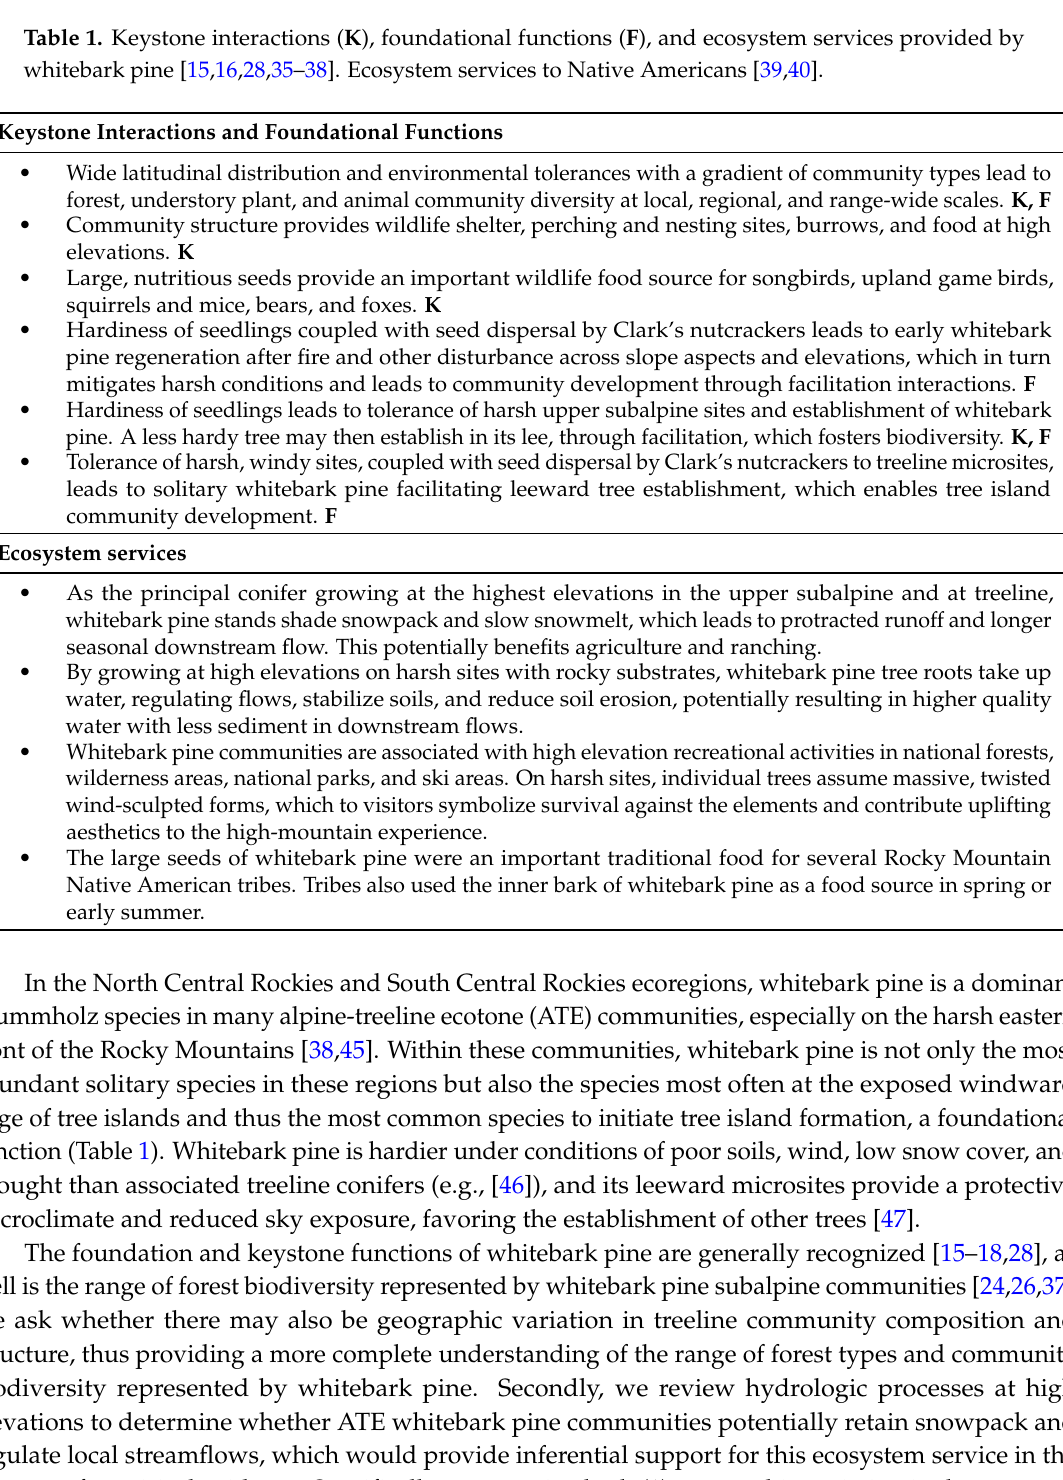
Table 1. Keystone interactions ( K ), foundational functions ( F ), and ecosystem services provided